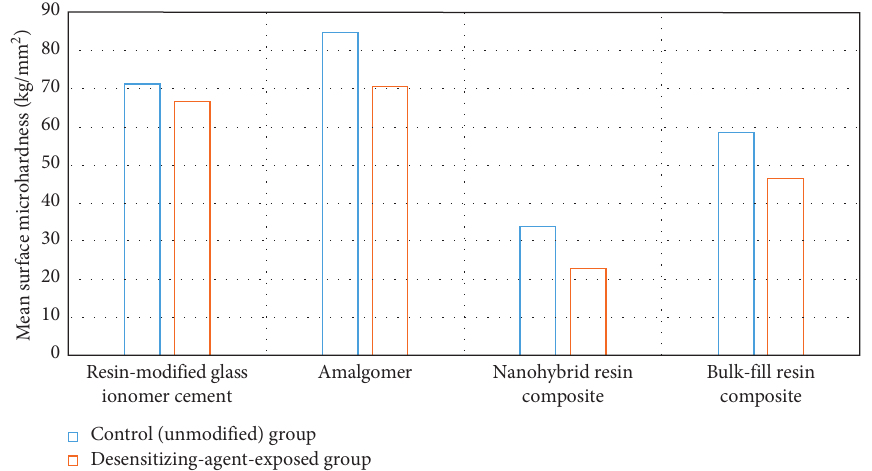
Figure 1: Graphical presentation of Student’s t -test of surface microhardness (kg/mm 2 ) of the tested materials.